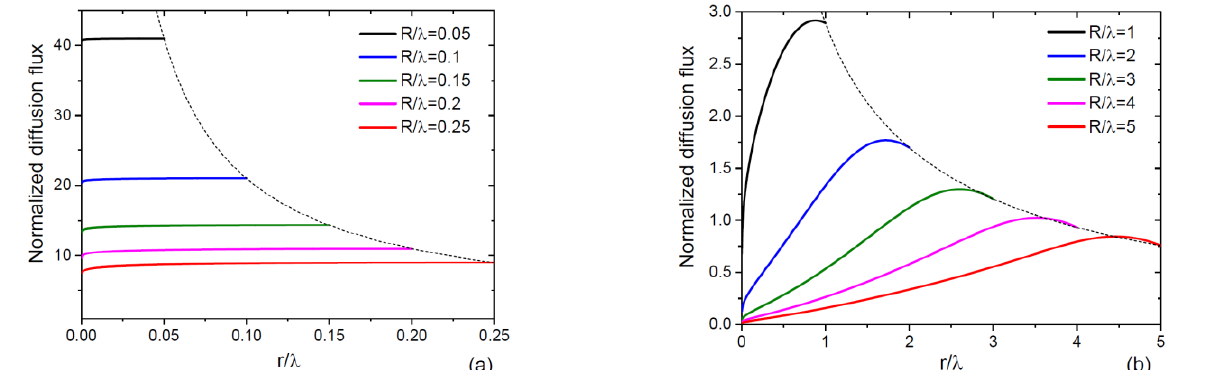
Figure 2. Normalized diffusion flux into 2D island on the NW top versus its non-dimensional radius r / λ for different R / λ between ( a ) 0.05 and 0.25, and ( b ) 1 and 5. The dashed lines show the fluxes at r = R . The fluxes are almost independent of the island radius for “thin NWs” in ( a ), and highly dependent on the radius for “thick” NWs in ( b ). The axial growth rate enhancement due to surface diffusion reaches a factor of 41 for the thinnest NWs with R / λ = 0.05 in ( a ) and is lower than 3 for thicker NWs with R / λ ≥ 1 in ( b